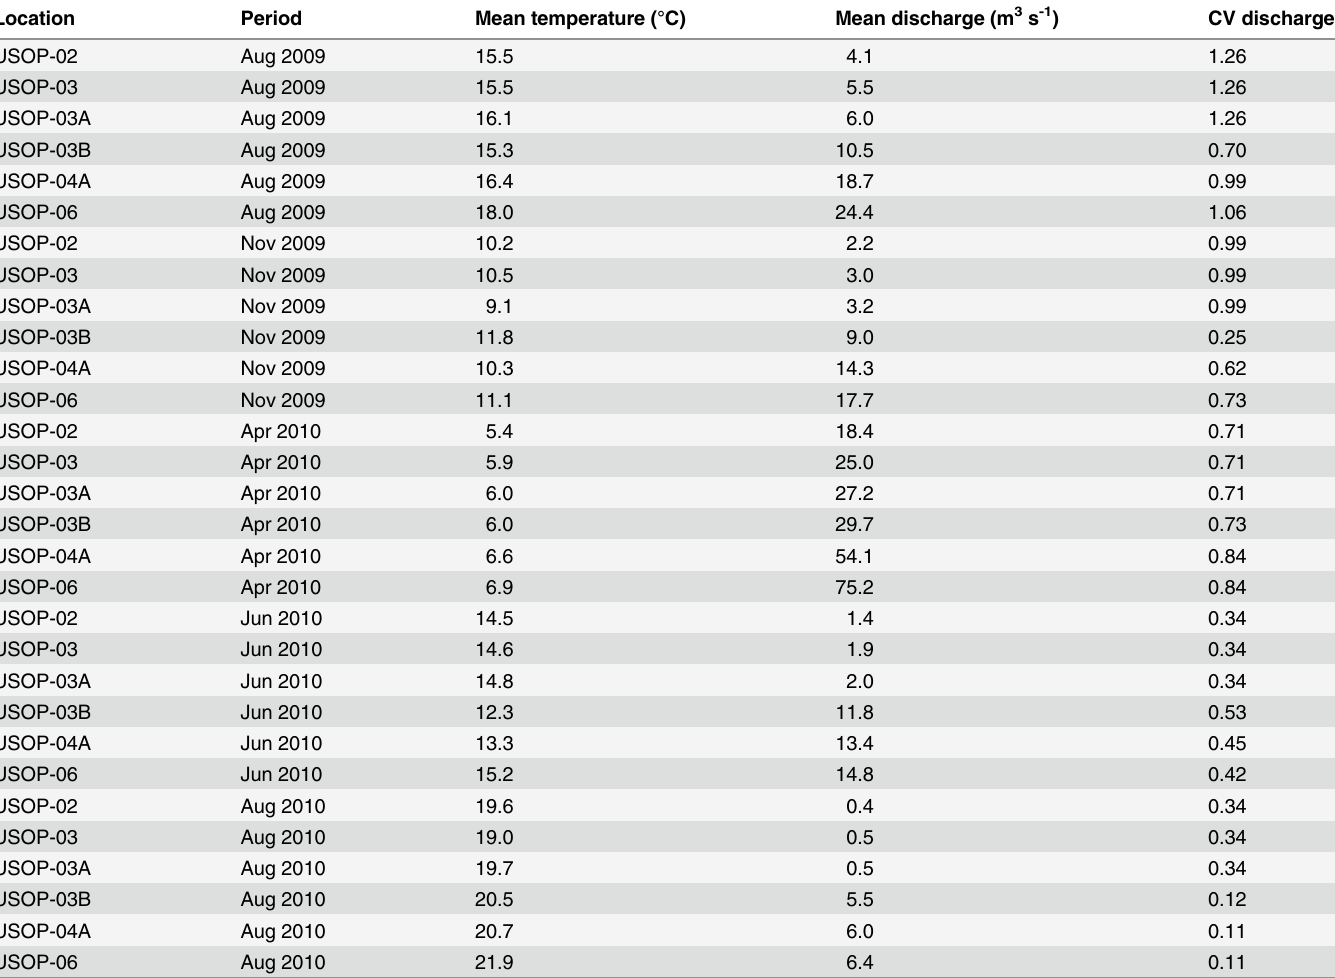
Table 2. Mean temperature, mean daily discharge, and discharge coefficient of variation (CV) for the 30 days preceding each survey at seasonal